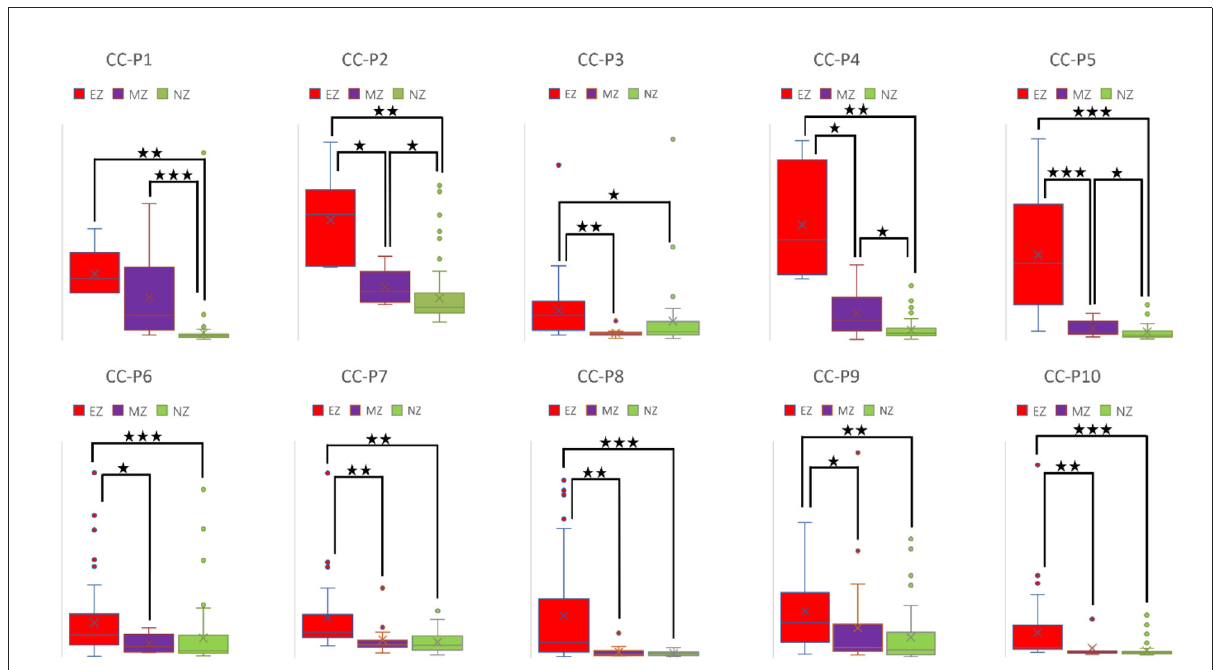
FIGURE3 Box plot of CC of all ten patients for EZ, MZ, and NZ (P1 represents patient 1; ⋆ represents p < 0.05 with EZ > MZ, EZ > NZ, or MZ > NZ; ⋆⋆ represents p < 0.001 with EZ > MZ, EZ > NZ, or MZ > NZ; ⋆⋆⋆ represents p < 0.00001 with EZ > MZ, EZ > NZ, or MZ > NZ; Mann–Whitney U -test [two–tailed]). CC, clustering coefficient; EZ, epileptogenic zone; MZ, margin zone; NZ, normal zone.